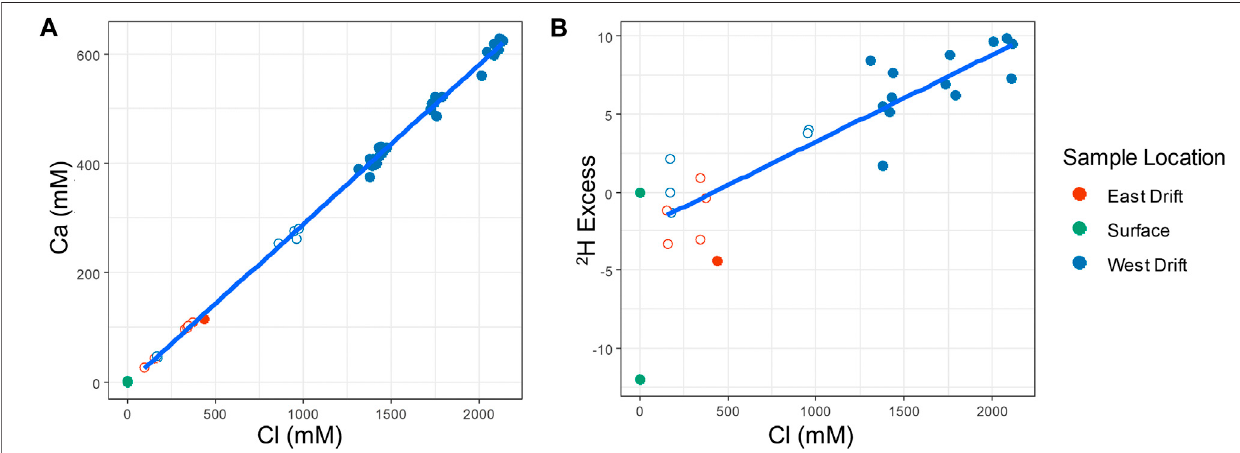
FIGURE 5 | Diagrams showing mixing in Soudan groundwaters. (A) Ca 2+ concentrations versus Cl − concentrations in Soudan borehole water, with the blue line indicating a regression based on thesevalues ( R 2 = 0.9979). Filled red or blue points represent samples taken from downward angled boreholes, while open red or blue pointsindicatesamplestakenfromhorizontalorupwardboreholes.GreenpointsaresurfacewatersamplestakenfromaspringinthetownofSoudan,MNandfromthe nearby Lake Vermillion. (B) Deuterium excess, as compared to Ely, MN precipitation, versus Cl − concentrations in Soudan borehole water, with the blue line indicating a regression based on thesevalues ( R 2 = 0.8122). Filled red or blue points represent samples taken from downward angled boreholes, while open red or blue points indicate samples taken from horizontal or upward boreholes. Green points indicate deuterium excess of Lake Vermillion sample and an average of Ely, MN precipitation deuterium excess, which is by de fi nition 0.